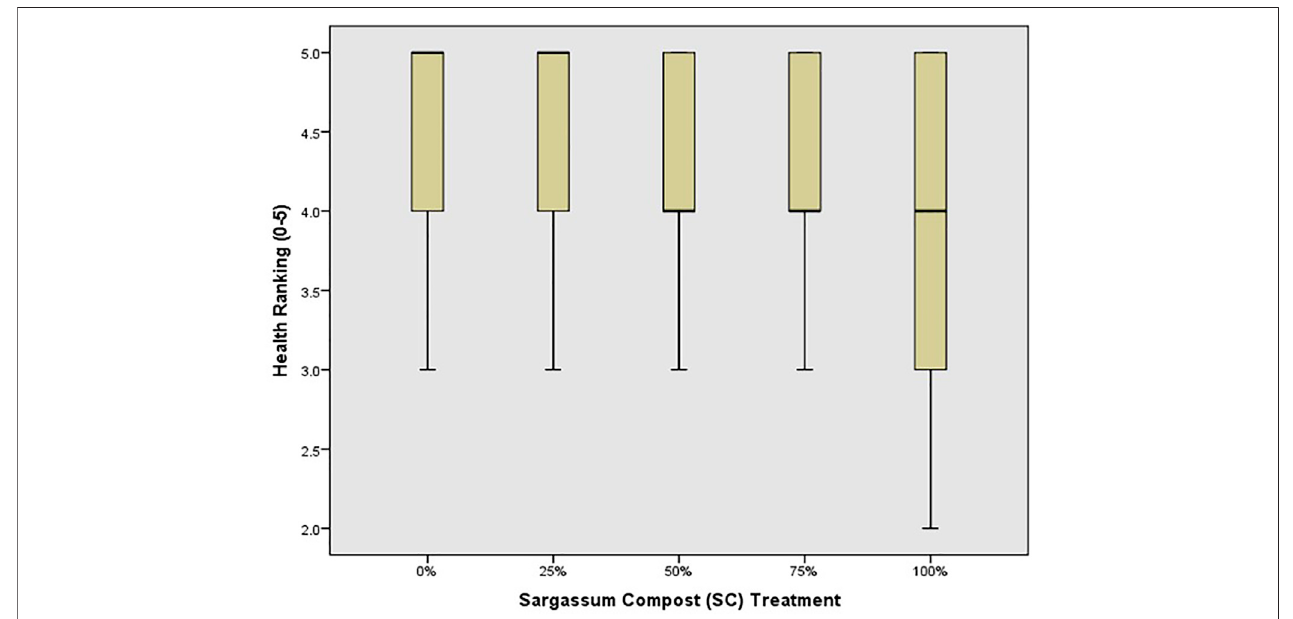
FIGURE 3 | Median health rank (bar), 25 – 75% range (box), and non-outlier range (whisker) for red mangrove seedlings in each treatment, indicating the % Sargassum spp. compost (SC).